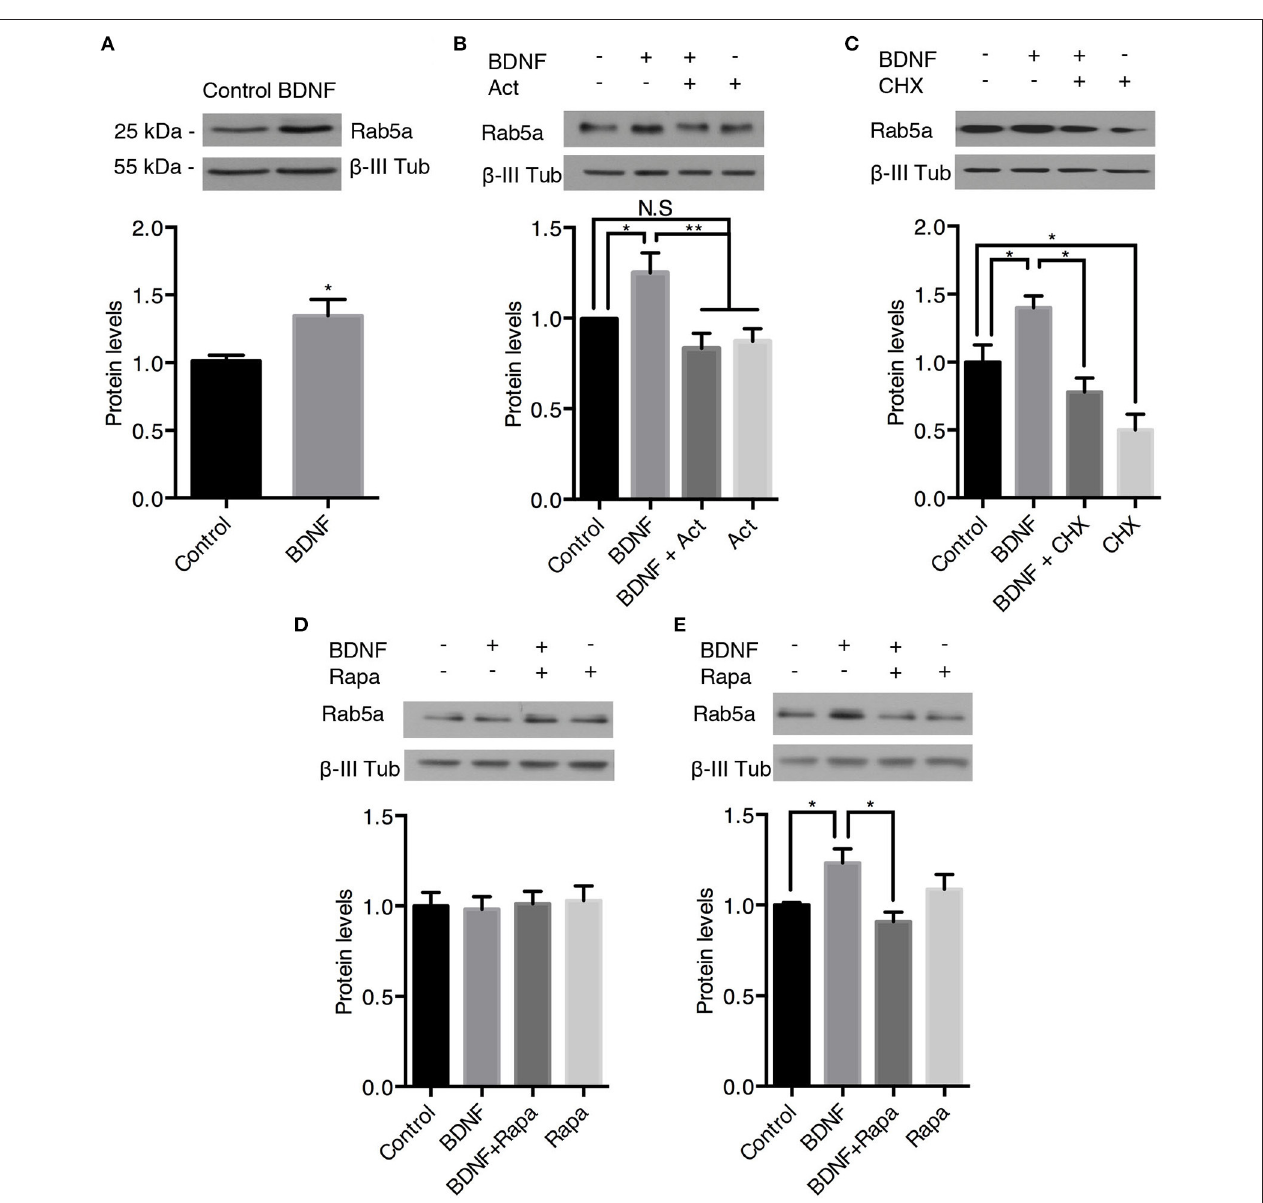
FIGURE 7 | BDNF increases the protein levels of Rab5a. The Rab5a and ß-III tubulin levels in hippocampal neurons (9 DIV) stimulated with BDNF for 24h (A) in the presence or absence of Actinomycin D (B) or cycloheximide (CHX) (C) . Bottom panel, densitometric quantification of the Ra5a levels normalized to the ß-III tubulin levels. The data represent 5 independent experiments. The results are expressed as the mean ± SEM. * p < 0.05; ** p < 0.01 by ANOVA with Bonferroni’s posttest. (D,E) Ra5a levels after 4h (D) or 12h (E) of treatment with rapamycin (Rapa) in the presence or absence of BDNF. Bottom panel, densitometric quantification of the Ra5a levels normalized to the ß-III tubulin levels. The data represent four independent experiments. The results are expressed as the mean ± SEM. * p < 0.05; ** p < 0.01 by ANOVA with Bonferroni’s posttest.